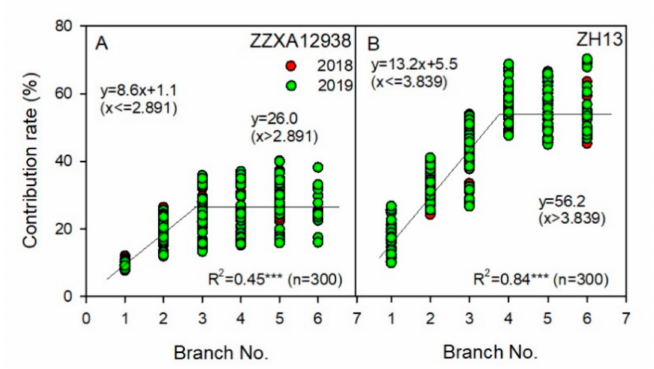
Figure 9. The relationship between branch yield contribution rate and branch number for ( A ) ZZXA12938 and ( B ) ZH13. Markers with different colors represent different growing season; *** indicates that the correlation is significant at the p ≤ 0.001